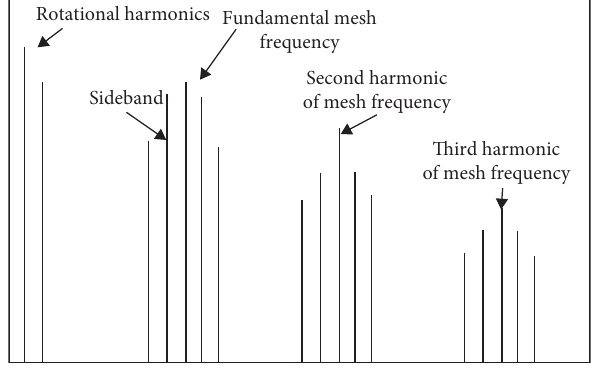
Figure 3: Harmonic contribution for the transmission